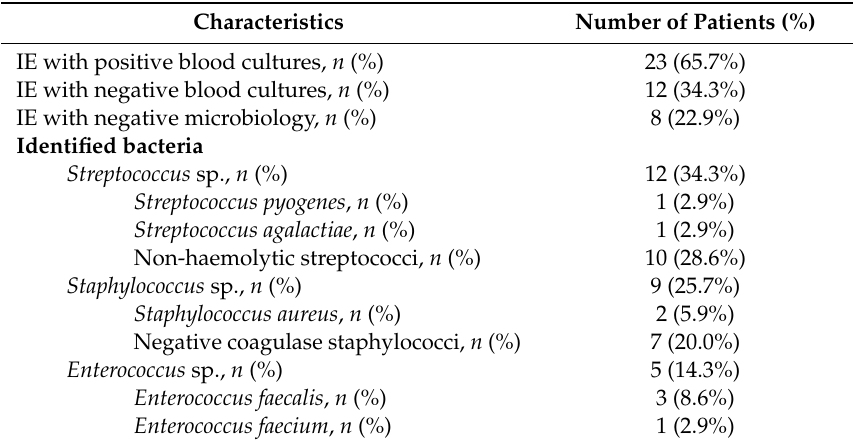
Table 3. Microbiology results.